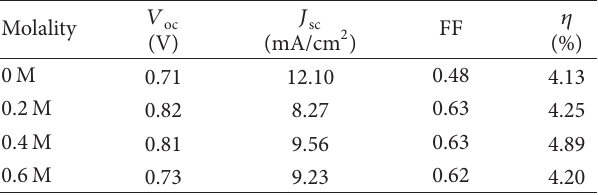
T 3: Photovoltaic parameters of the DSSC based on the composite electrolytes with 1-butyl-3-methylimidazolium chloride at different molalities.